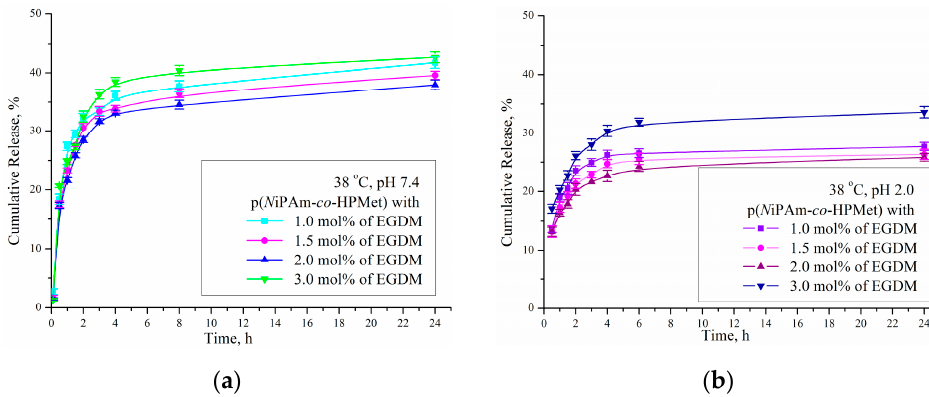
Figure 9. In vitro cumulative release of naproxen from p( N iPAm- co -HPMet) hydrogels at 38 °C: ( a ) at pH 7.4, ( b ) pH 2.0. In each figure, error bars represent the standard deviation of three replicates. The results show higher values of released naproxen at a temperature above LCST.